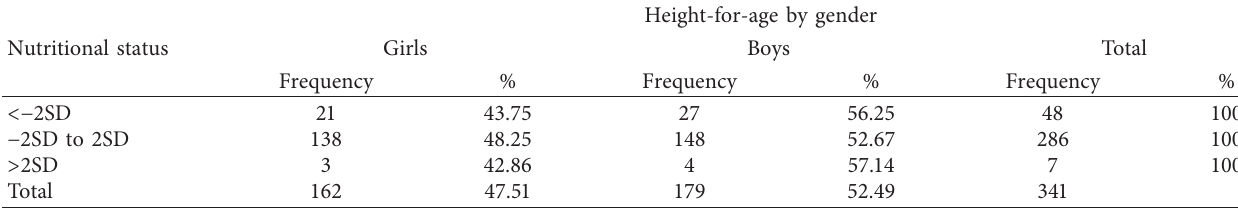
Table 4: Prevalence of stunting by gender among primary school children in Kutaber district, Northeast Ethiopia, 2019 ( n �